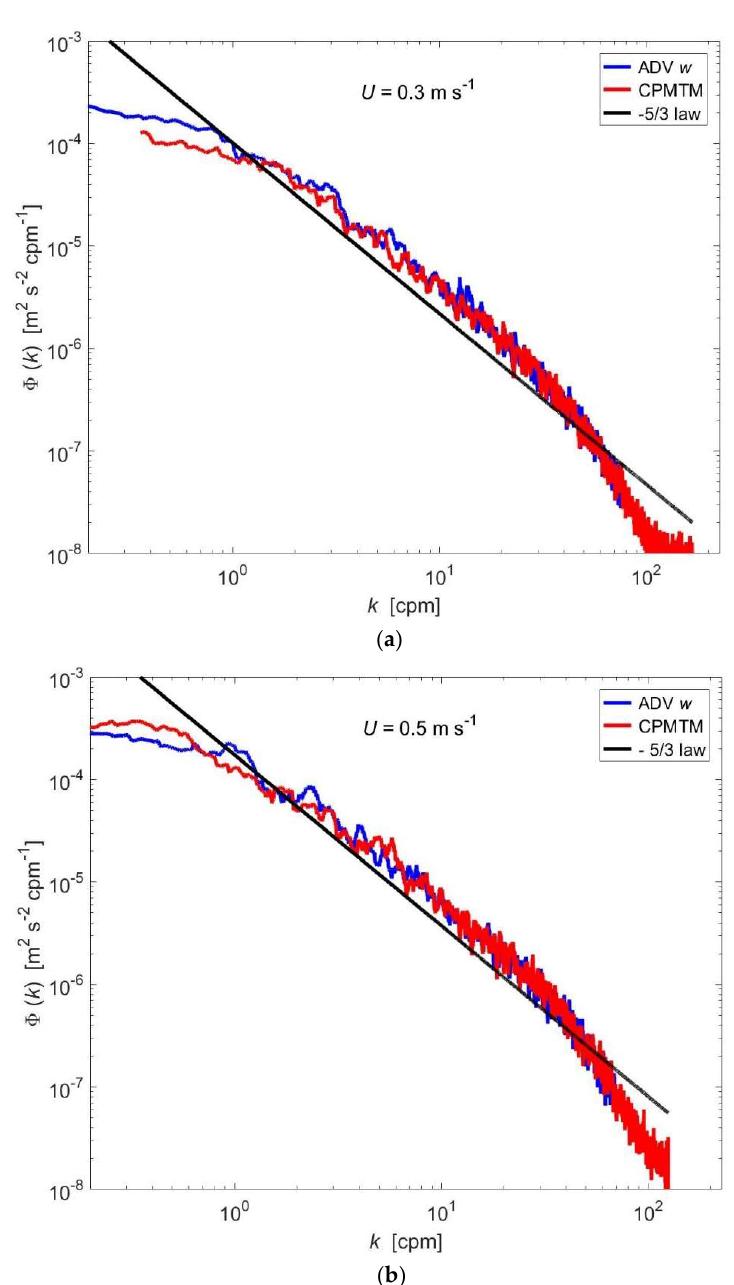
Figure 4. The velocity spectrum measured by the CPMTM and the ADV in a flume at two speeds ( U = 0.3 and 0.5 m s −1 ), where the red line is the CPMTM, the blue line is the ADV w component, and the black lines are the—5/3 decay law. ( a ) Measurement results at U = 0.3 m s −1 ; ( b ) Measurement results at U = 0.5 m s −1 .